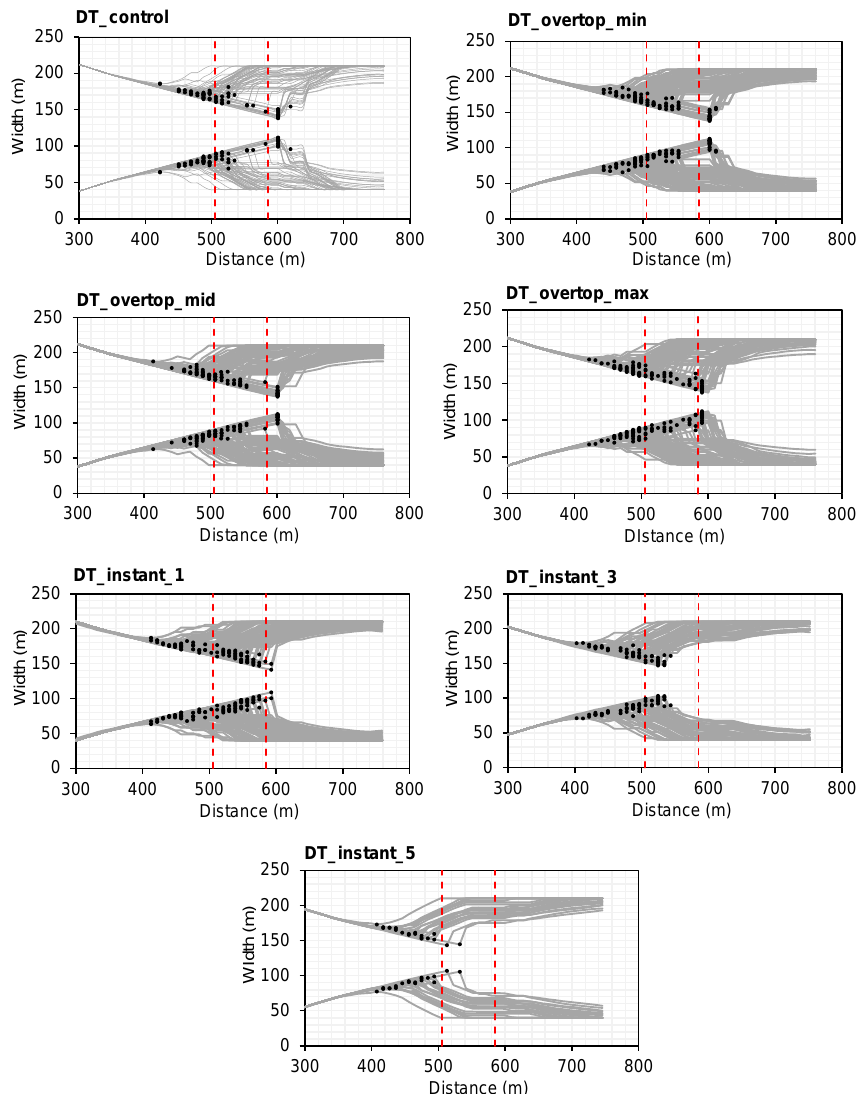
Figure 9. Final breach planforms (grey lines) for all modelled scenarios. Precise locations of critical flow constriction are highlighted by black dots. Simulations possessing flow constriction locations that fell between the red dashed lines (distance 505–585m) were deemed to be behavioural and assigned positive likelihood